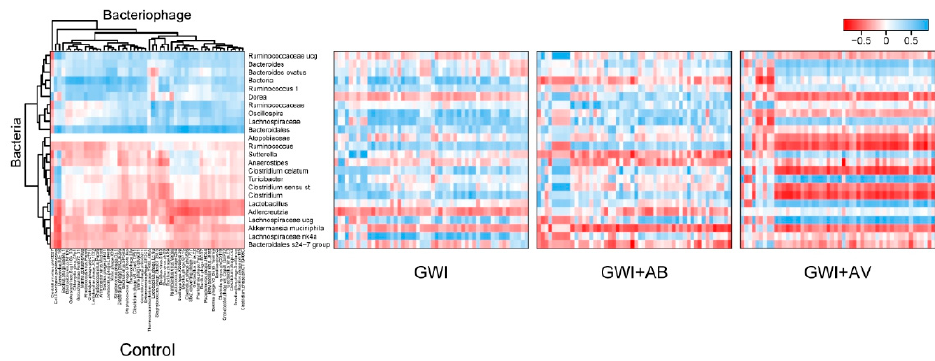
Figure 3. GWI and intervention alterations in bacteria-bacteriophage interactions. Heatmap of Pearson correlations between bacteria (rows) and bacteriophages (columns) are shown. Clustering was performed on the control group (left), and the same clustering order maintained in the correlation plots of Gulf War illness (GWI), GW chemicals and antibiotics (GWI + AB), and GW chemical and antiviral (Ribavirin) (GWI + AV) groups